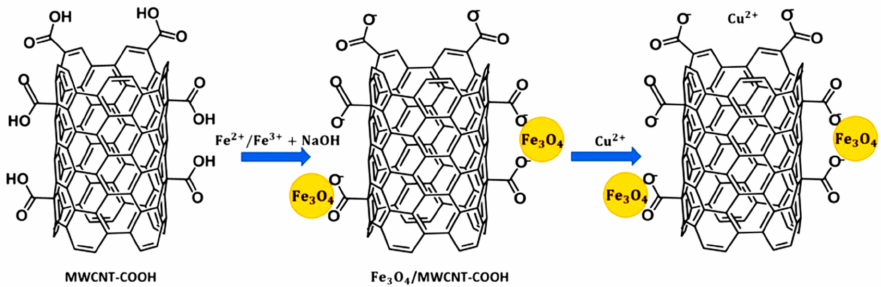
Figure 3. Synthesis of the magnetite decorated MWCNTs preliminary modified with acid groups. Reprinted with permission from [114].